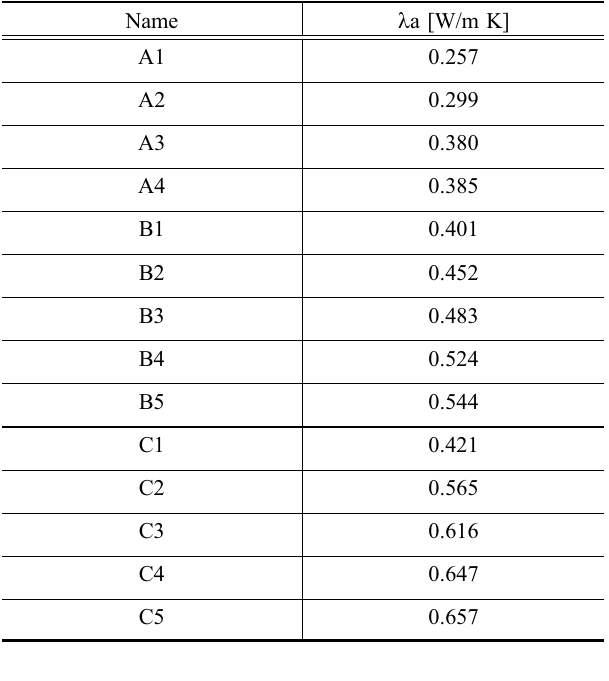
Table 10 Values of the thermal conductivity of the concretes with sand in W/m K.